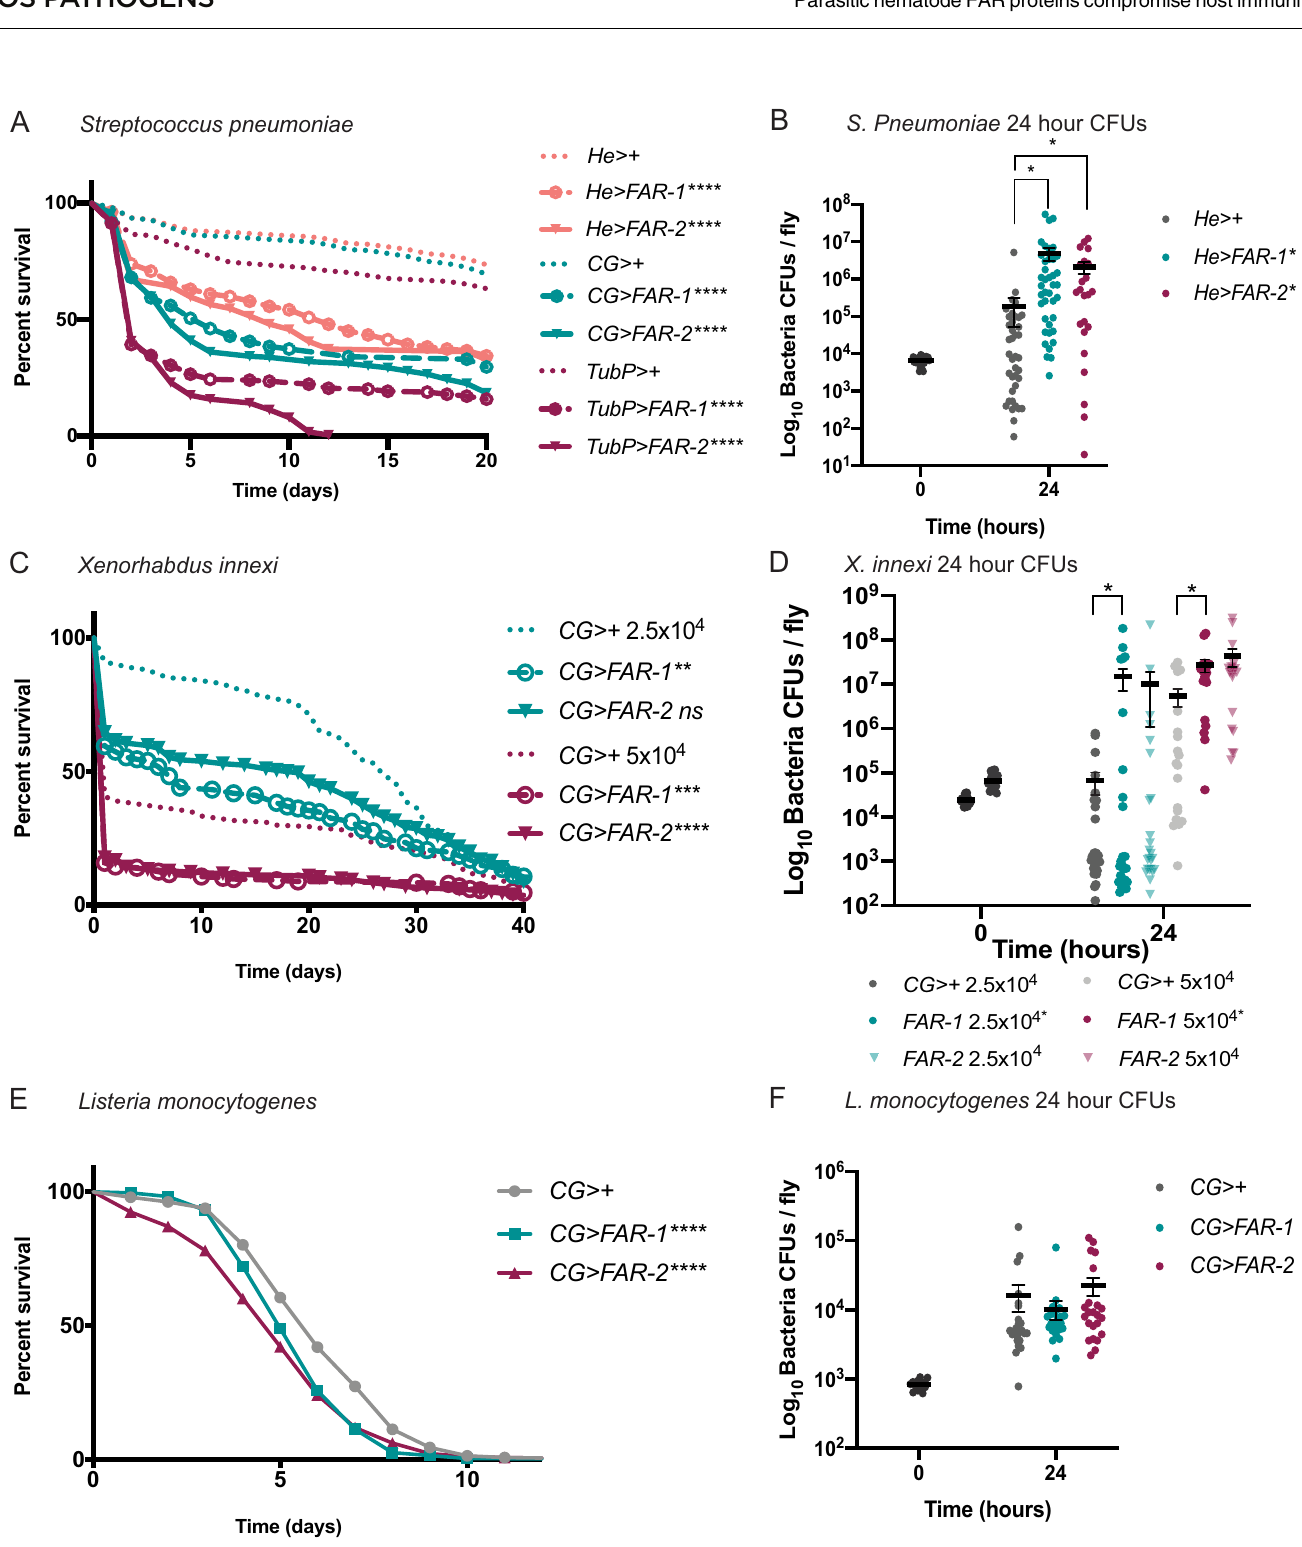
Fig 2. Transgenic FAR expression significantly decreases fly survival and increases bacterial load 24-hours post-injection. Flies were injected with specified doses of various pathogens. Survival was monitored daily and bacterial load was measured 24 hours post-injection. A&B) Flies FAR-1 & -2 expressed with a tubulin driver (TubP), a fat body, hemocyte and lymph gland specific driver (CG), and a hemocyte only driver (He) were injected with 7,000 CFUs of Streptococcus pneumoniae . Survival curves of flies are shown in (A) and bacterial CFUs in the He driver flies at 24-hour post injection in (B). C&D) Flies with FAR-1 & -2 expression with the